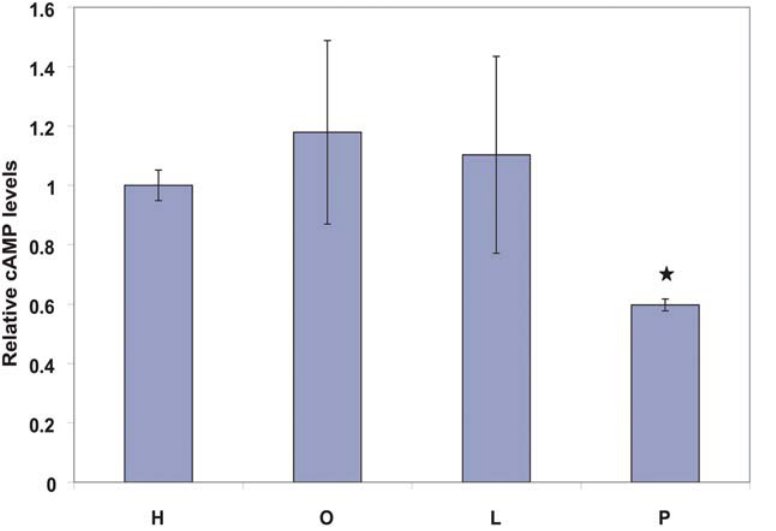
Figure 3. Effect of FFA-treatments on intracellular cAMP levels. Cells were treated for 24 h with 0.7 mM of different types of FFA and the levels of intracellular cAMP were measured. H=Control medium, O=0.7 mM oleate, L=0.7 mM linoleate, and P=0.7 mM palmitate. w , p , 0.01 by a two-tailed t-test. doi:10.1371/journal.pone.0003860.g003 PLoS ONE |